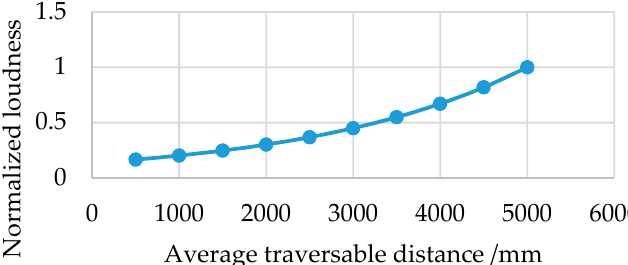
Figure 9. The relationship between the average traversable distance and instrument loudness.